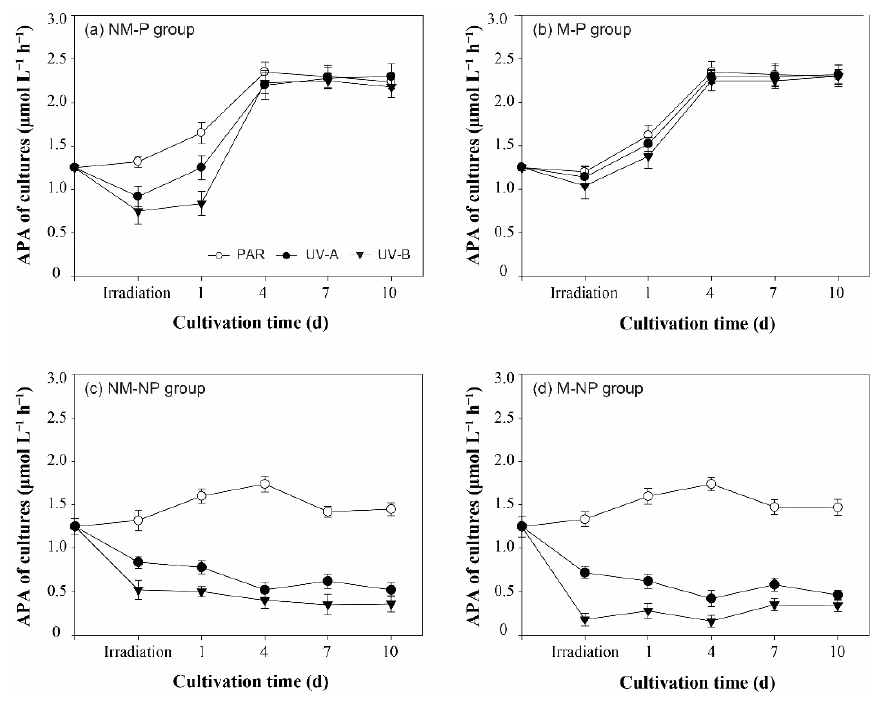
Figure 7. APA of algal cultures in ( a ) NM-P group, ( b ) M-P group, ( c ) NM-NP group and ( d ) M-NP group after different irradiation treatment.